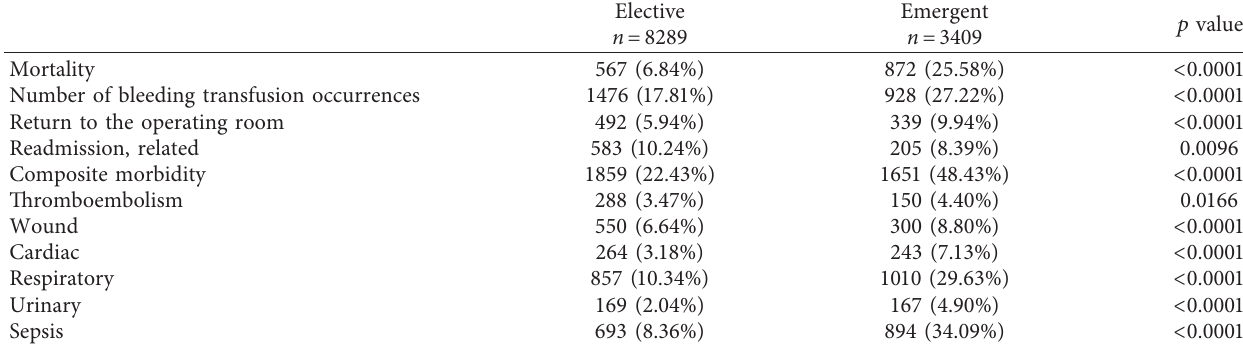
Table 3: Univariate analysis: 30-day postoperative outcome measures of elective colectomies versus emergent colectomies. Elective